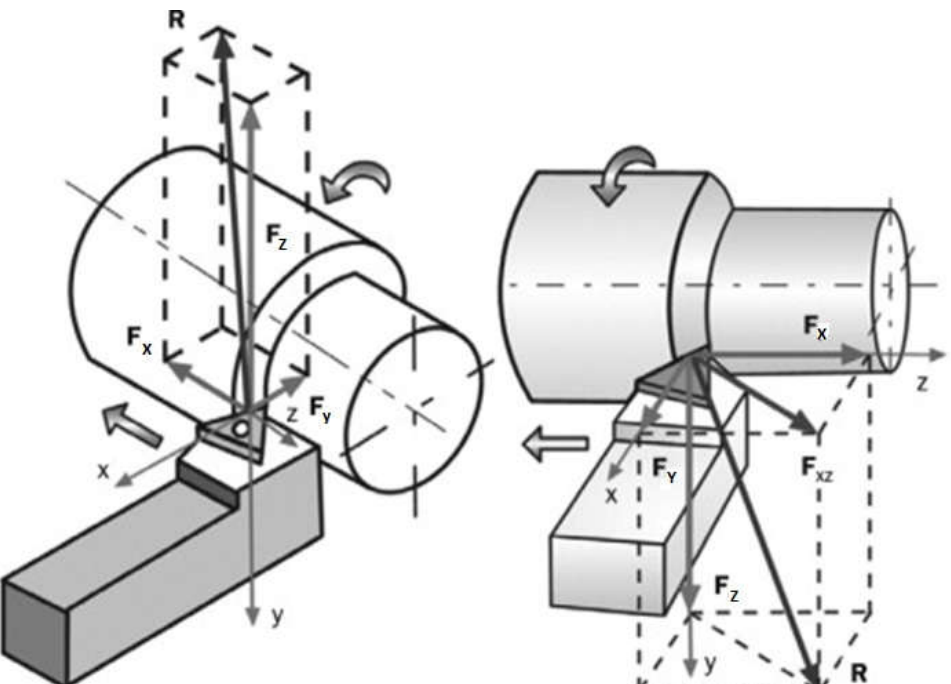
Figure 4. Schematic representation of various forces acting on a tool [37].